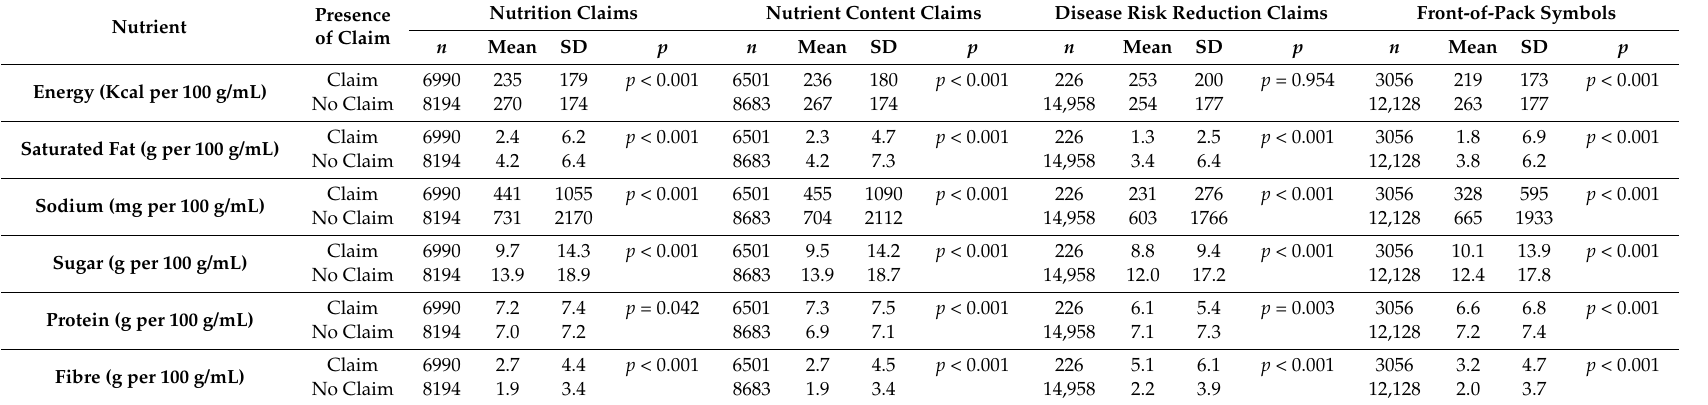
Table 5. Comparison of the nutritional composition of foods and beverages with and without nutrition claims ( n = 15,184). Presence Nutrient of